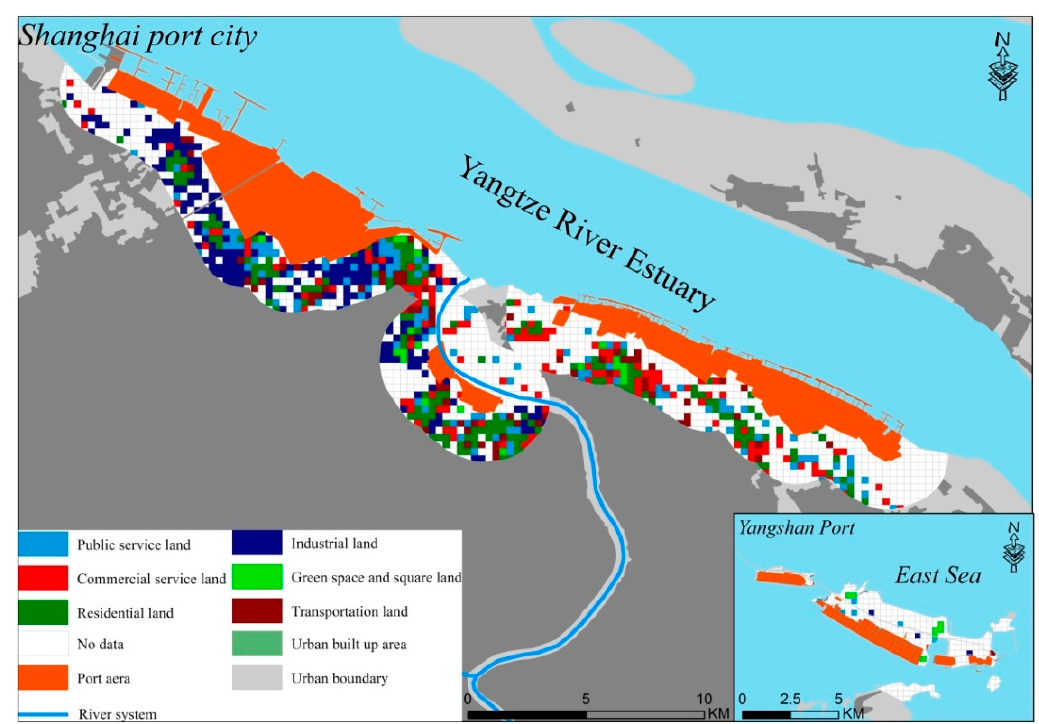
Figure 6. Distribution of urban functional areas on the Shanghai port–city interface (source: drawn by author).